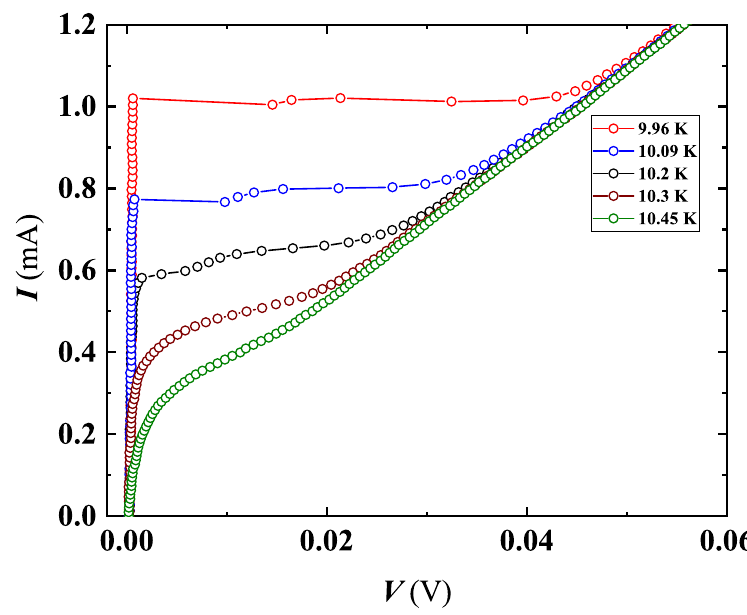
Figure 14. I-V characteristics for SO5, at selected T values close to T c . Less-marked resistive tails are now visible, whose values are reduced if compared to those detected in the film SR5 (see the Figure